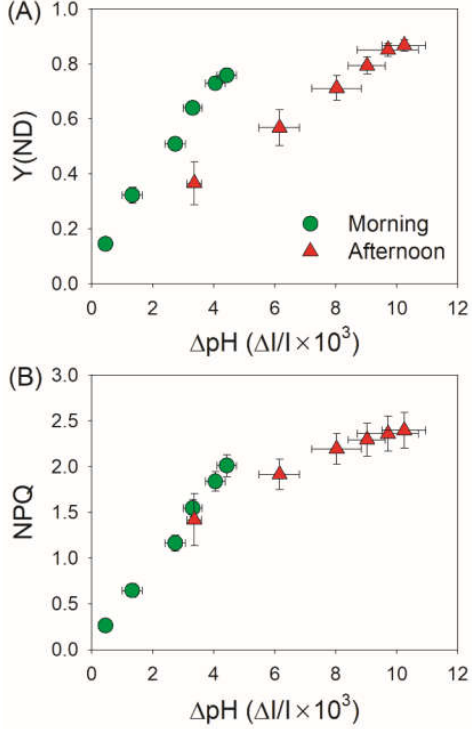
Figure 5. Changes in ( A ) Y(ND) and ( B ) NPQ as a function of ∆ pH for leaves of Vanilla planifolia measured in the morning and in the afternoon. Data are means ± SE ( n = 5).